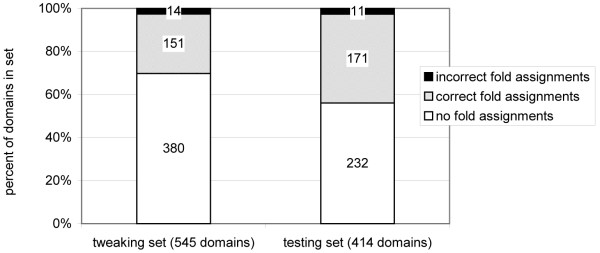
Fold level assignments.